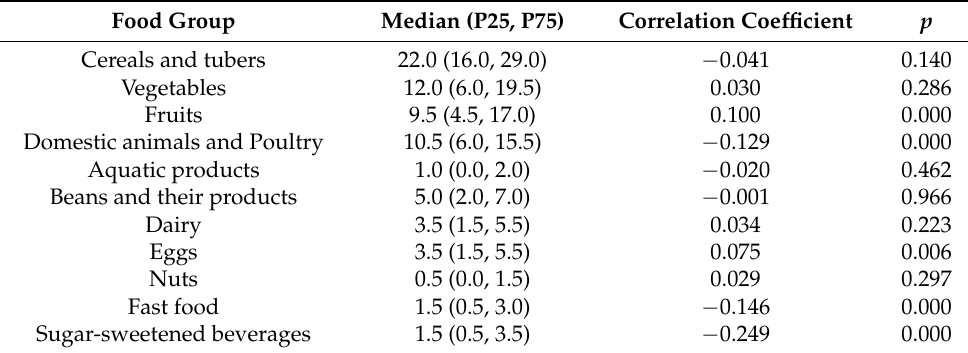
Table 4. Correlation between cognitive restraint eating and weekly consumption frequency of food and snacks.